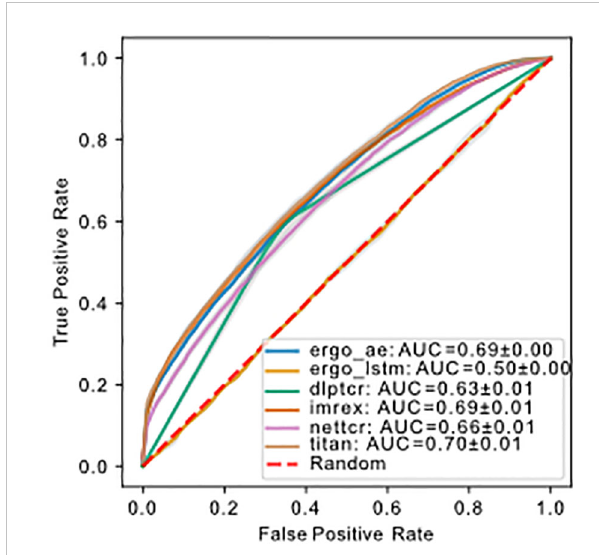
FIGURE 4 ROC of models predicting binding of TCR-pMHC trained and tested on d base using uniform splitting. The dashed red line indicates performance of random guessing. ROC curve for DLpTCR looks “ linear ” , because DLpTCR outputs a binary and not a continuous probability.